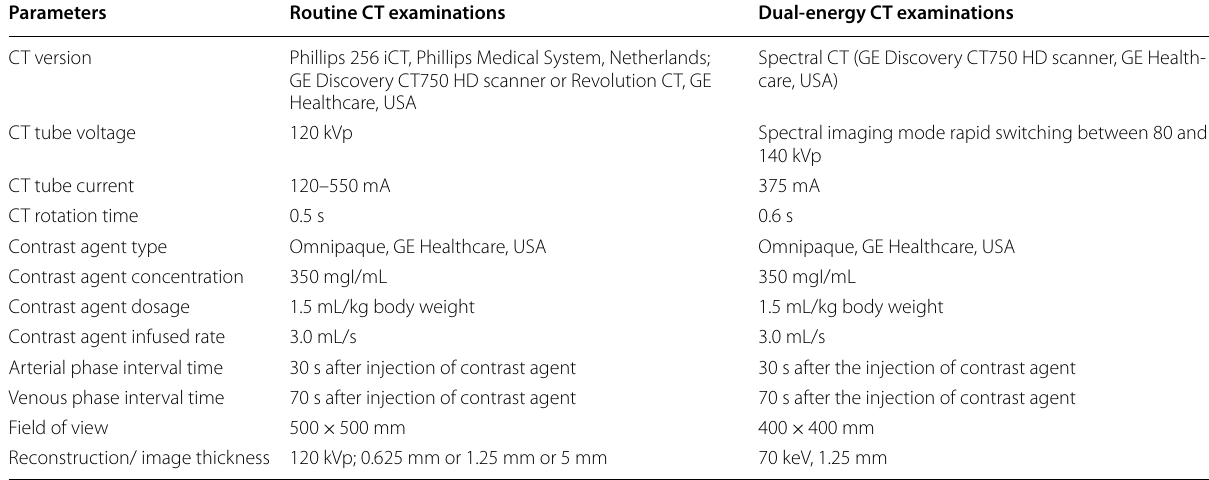
Table 2 CT imaging